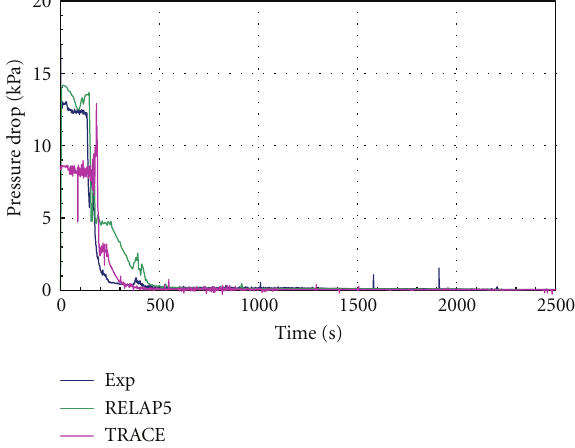
Figure 15: Intermediate leg 1 DP (pump side).